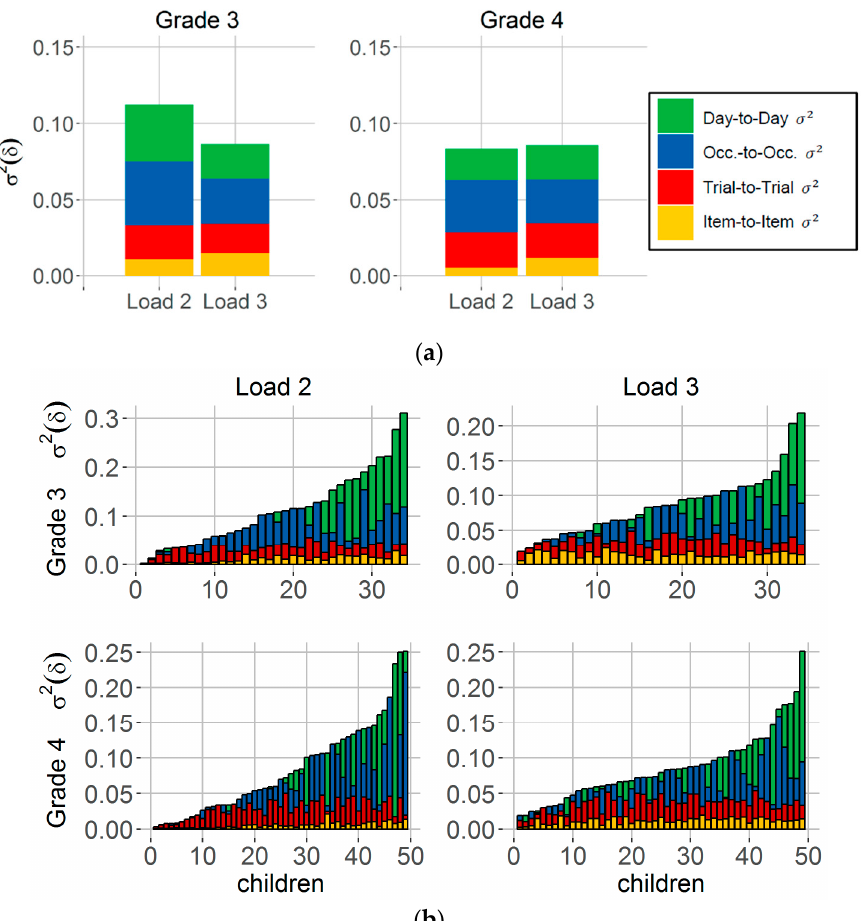
Figure 4. Variance components of spatial precision. ( a ) The size of each bar reflects the total amount of children’s averaged observed day-to-day variability separately for Grade 3 and Grade 4 students and load conditions (i.e., Load 2 and 3). This variability is decomposed into four different variance components that were estimated for each individual in each load condition. Variance components reflect variability of spatial precision from item-to-item (yellow), trial-to-trial (red), across occasions (Occ.; blue) and true day-to-day variability (green); ( b ) Each bar corresponds to children’s estimated item-to-item, trial-to-trial, occasion-to-occasion and day-to-day variance component of observed variability across days. Bars are ordered by their total size (i.e., variance of average performance across days) from very low (left) to very high (right) variability. N = 34 (Grade 3), n = 49 (Grade 4).